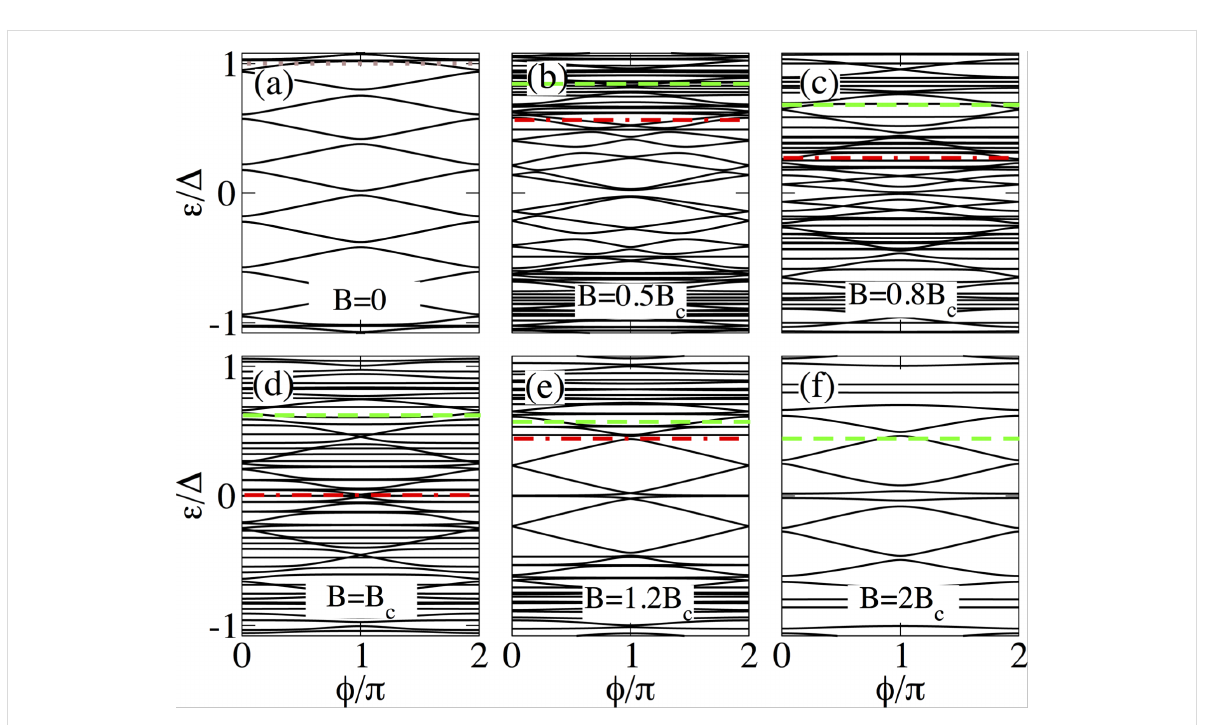
Figure 5: Same as in Figure 4 for a long junction with L N = 2000 nm and L S = 2000 nm. Note that, unlike short junctions, in this case the four lowest states for B > B c coexist with additional levels within the induced gap which arise because L N is